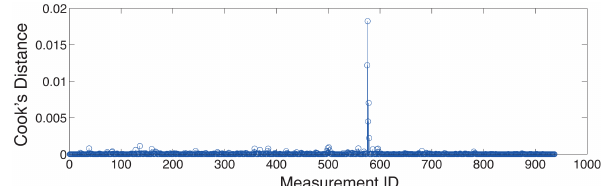
Figure 5. Cook’s distance of the measurements in the ETEX data